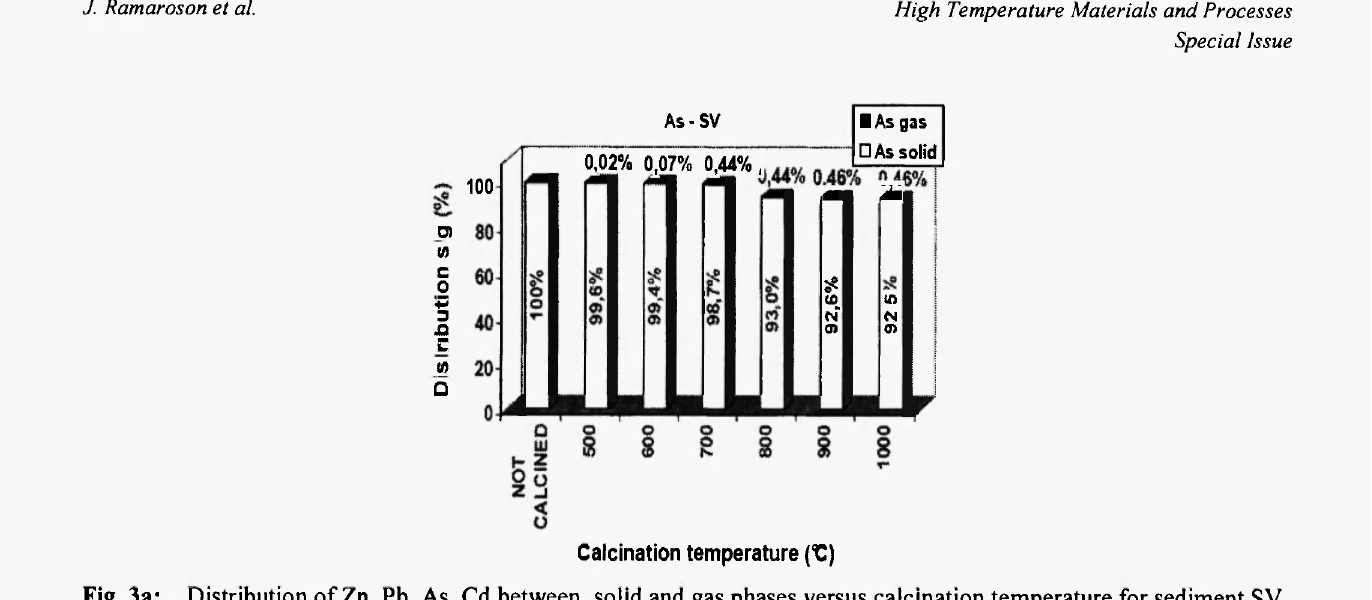
Calcination temperature (C) 3a: Distribution of Zn, Pb, As, Cd between solid and gas phases versus calcination temperature for sediment SV Fig. As-SV